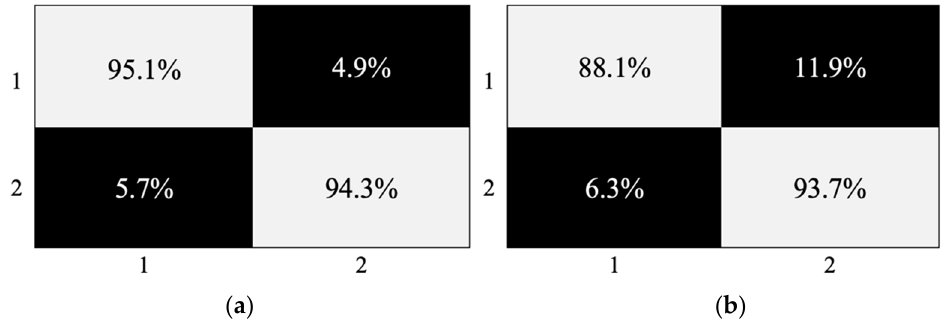
Figure 4. Confusion matrix illustrating the percentage of TP, FP, TN and FN for both the T1 ( a ) and T2/FLAIR ( b ) cohorts with a PLS-DA classification model after 1000 bootstraps.